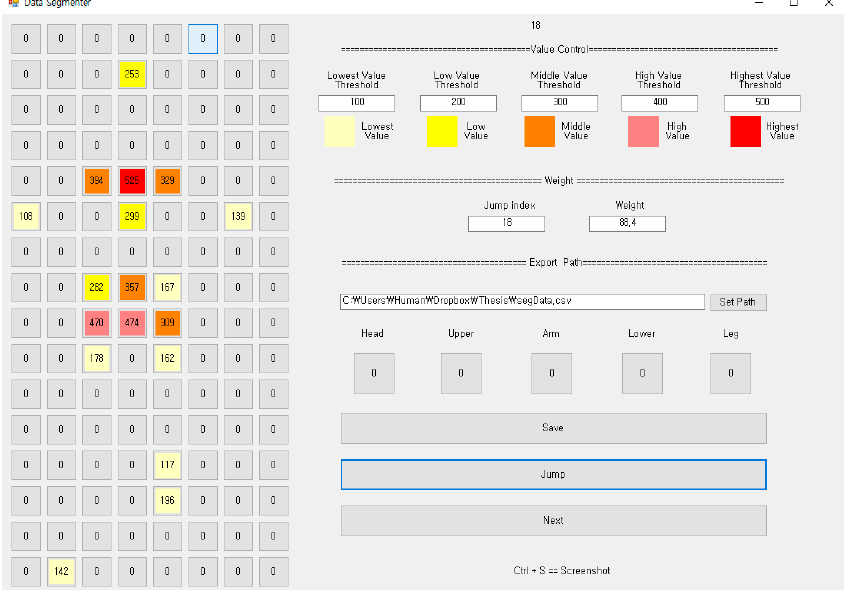
Figure 7. The pressure distribution before segmentation.